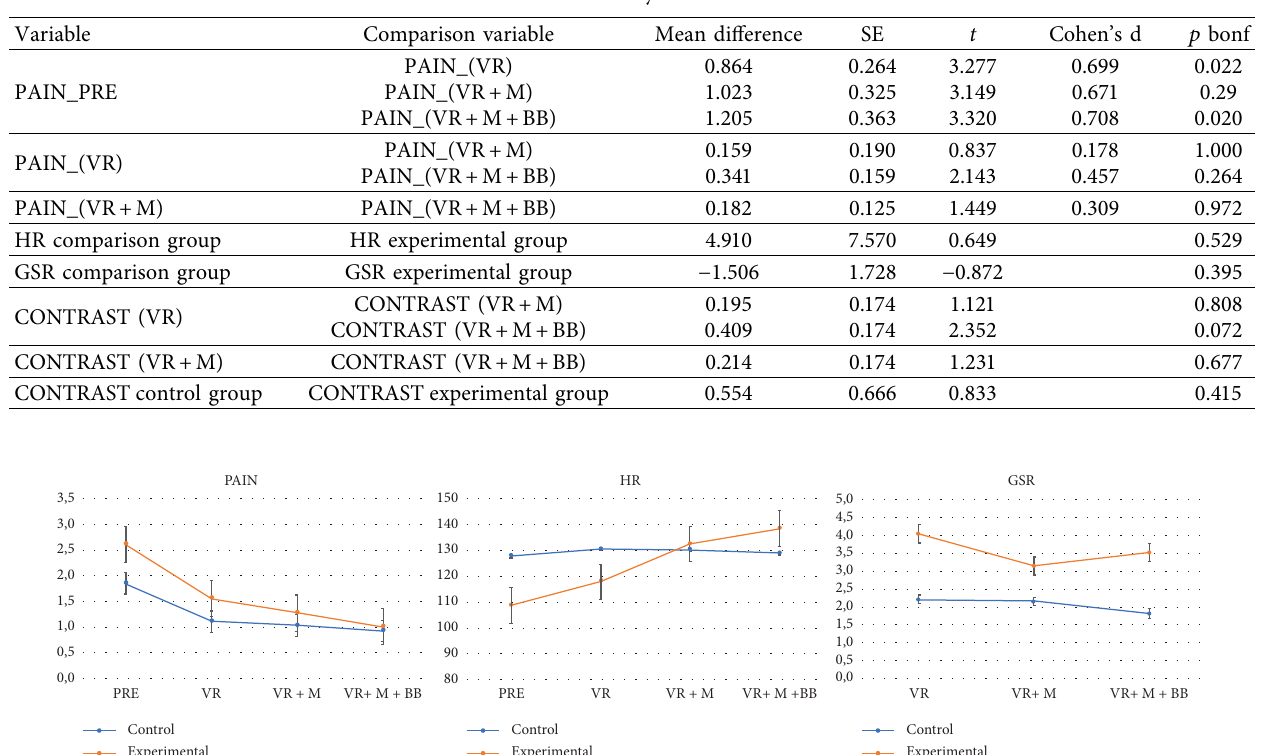
Table 6: Post-hoc analysis of the variables.